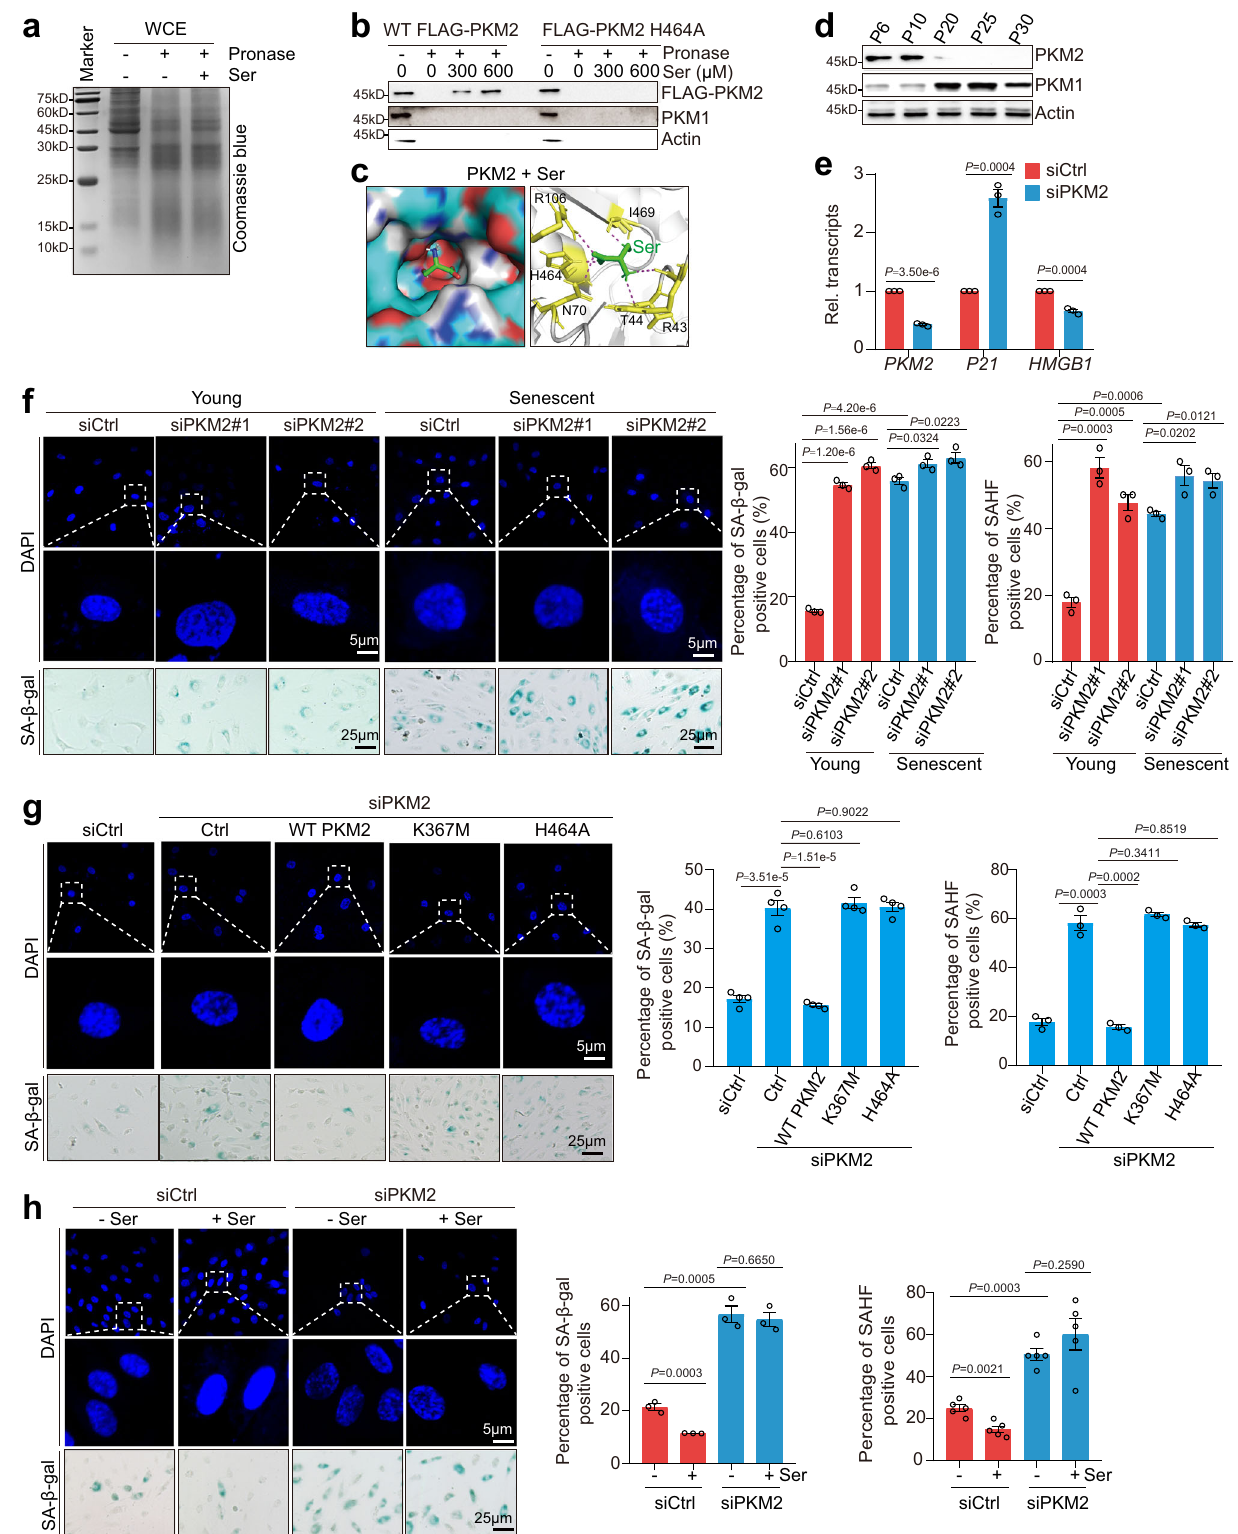
in shPHGDH HUVECs. Treatment with the ubiquitin-proteasome inhi- bitor, MG132, failed to restore the reduced PKM2 protein level in shPHGDH HUVECs (Supplementary Fig. 4g). However, treatment with leupeptin, an inhibitor for autophagy-lysosome pathway, rescued the reduced PKM2 in PHGDH-knockdown HUVECs (Fig. 3g). Moreover, knockdown of the lysosomal membrane receptor LAMP2A